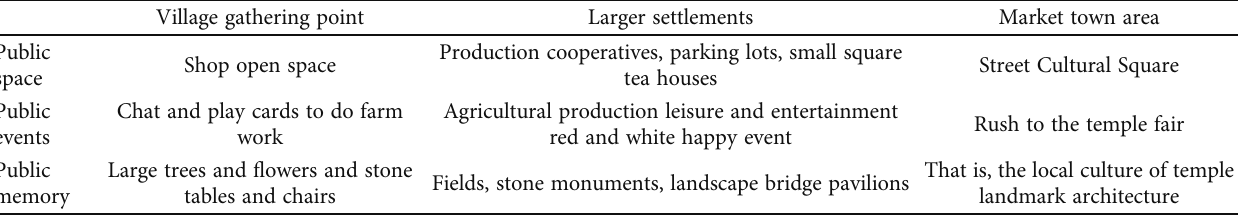
Table 2: The distribution of public memory of public activities in public